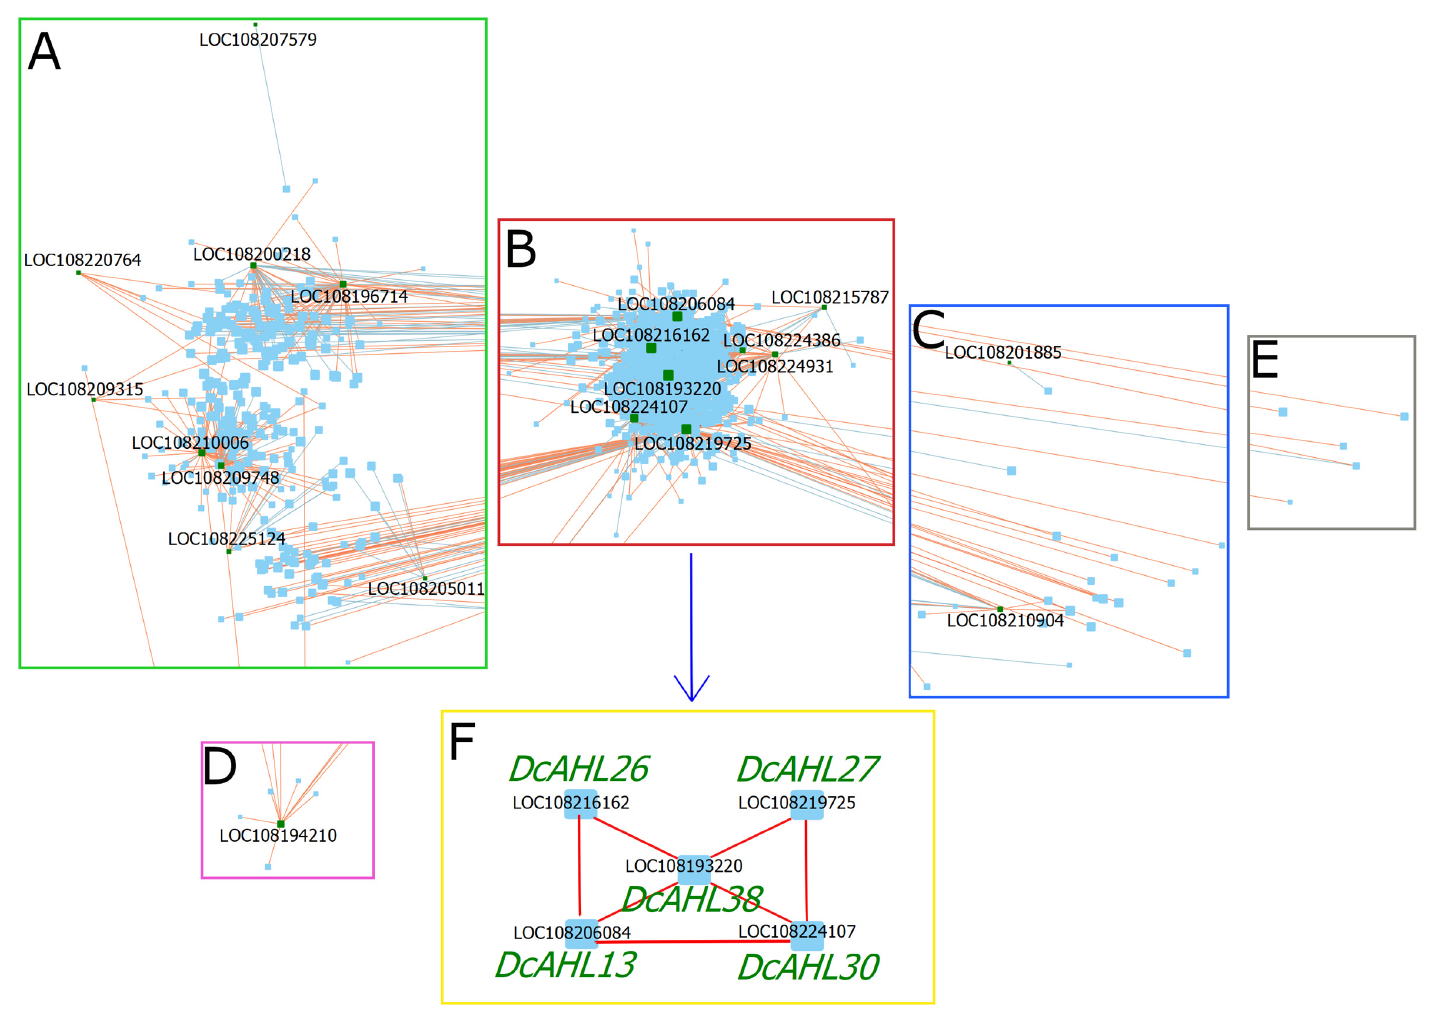
Figure 5. The coexpression network of genes differentially expressed in carrot storage roots. ( A – E ) Five clusters comprising DcAHL genes (shown as green nodes) and/or their first neighbors (shown as blue nodes); red and blue lines connecting genes represent positive and negative correlations between those genes, respectively. ( F ) A group of five potentially directly interacting DcAHL genes in Cluster-2